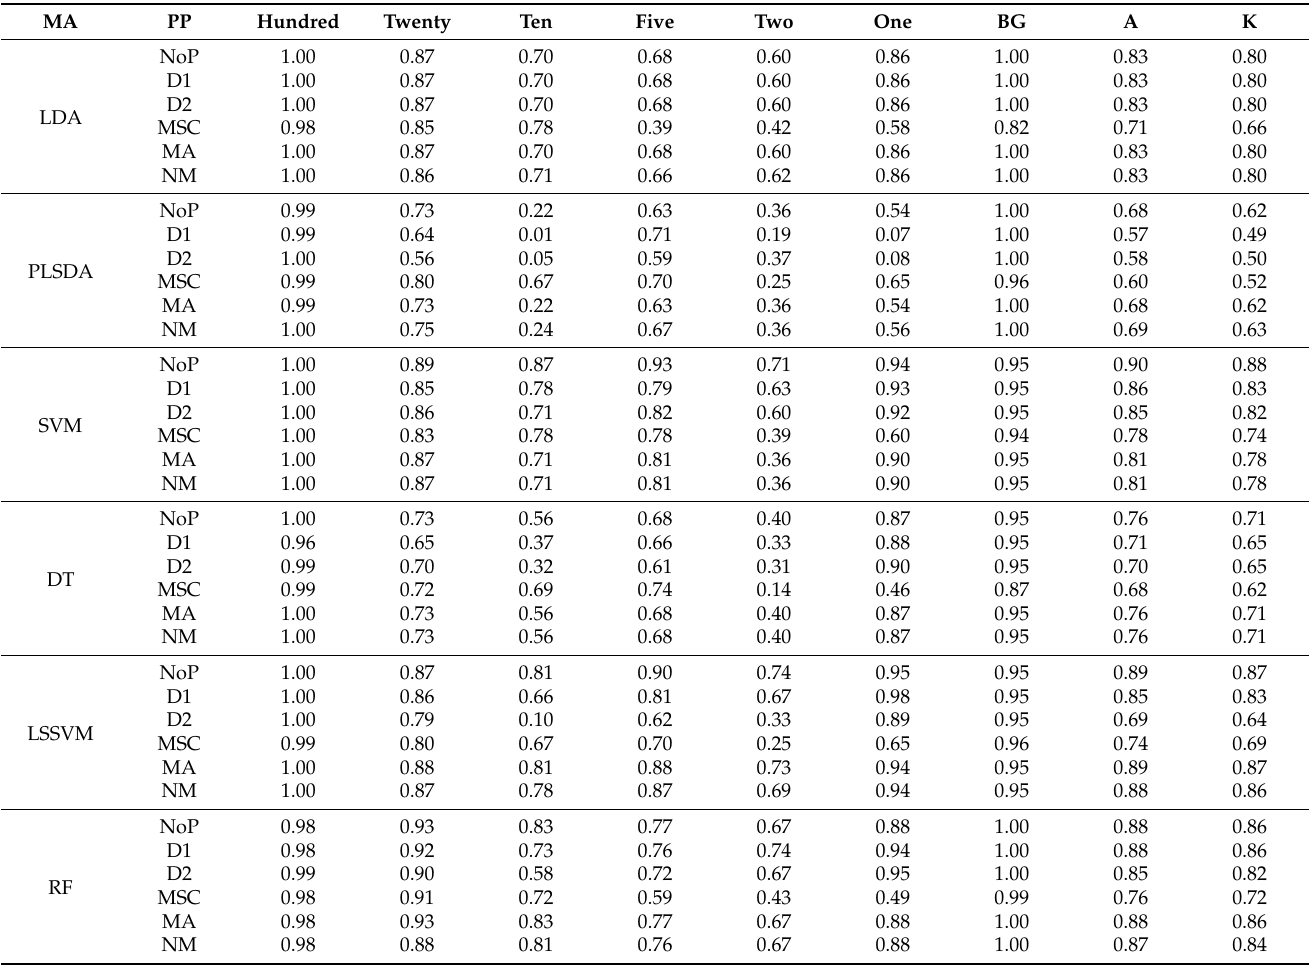
Table 2. Result of the classification of the diluted residues of potato as the accuracy ( A ) and kappa coefficient ( K ) based on chemometric methods.